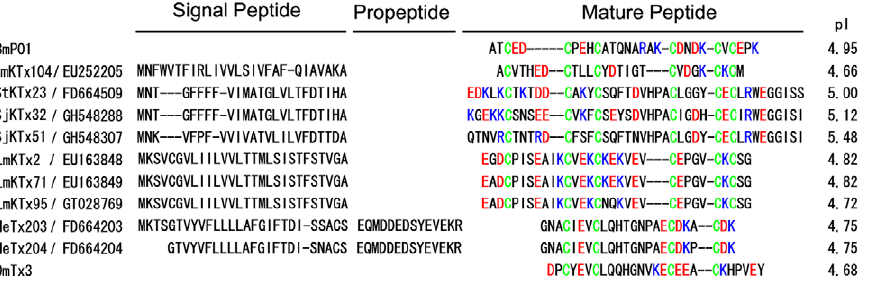
Figure 1. Sequence alignment of nine new KTxs. Cysteines are shadowed in green. Acidic and basic residues are shown in red and blue, respectively. Isoelectric points (pIs) were calculated using compute pI/Mw tool (http://web.expasy.org/compute_pi/).